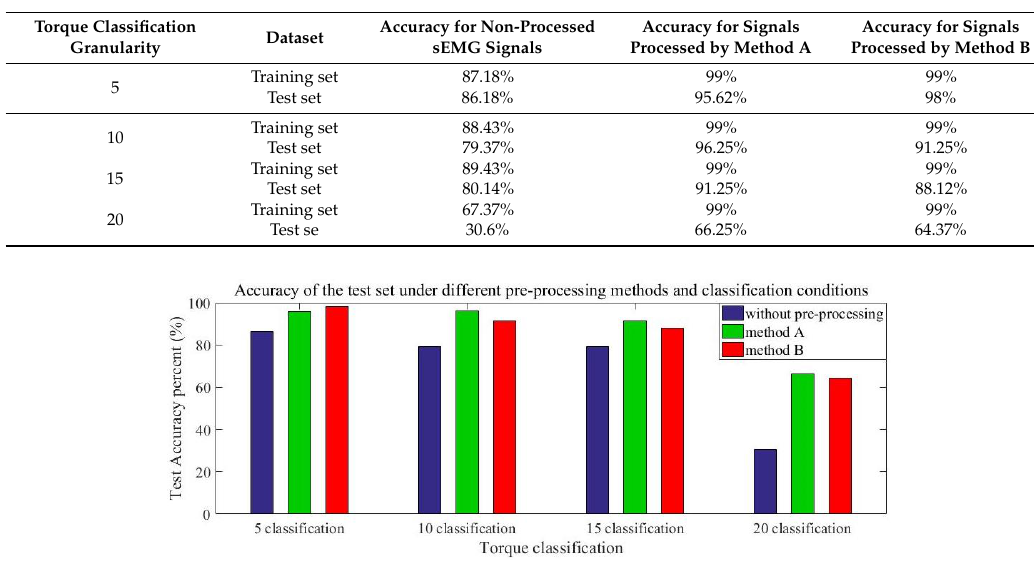
Figure 7. Accuracy of the test set under different preprocessing methods and classification conditions.